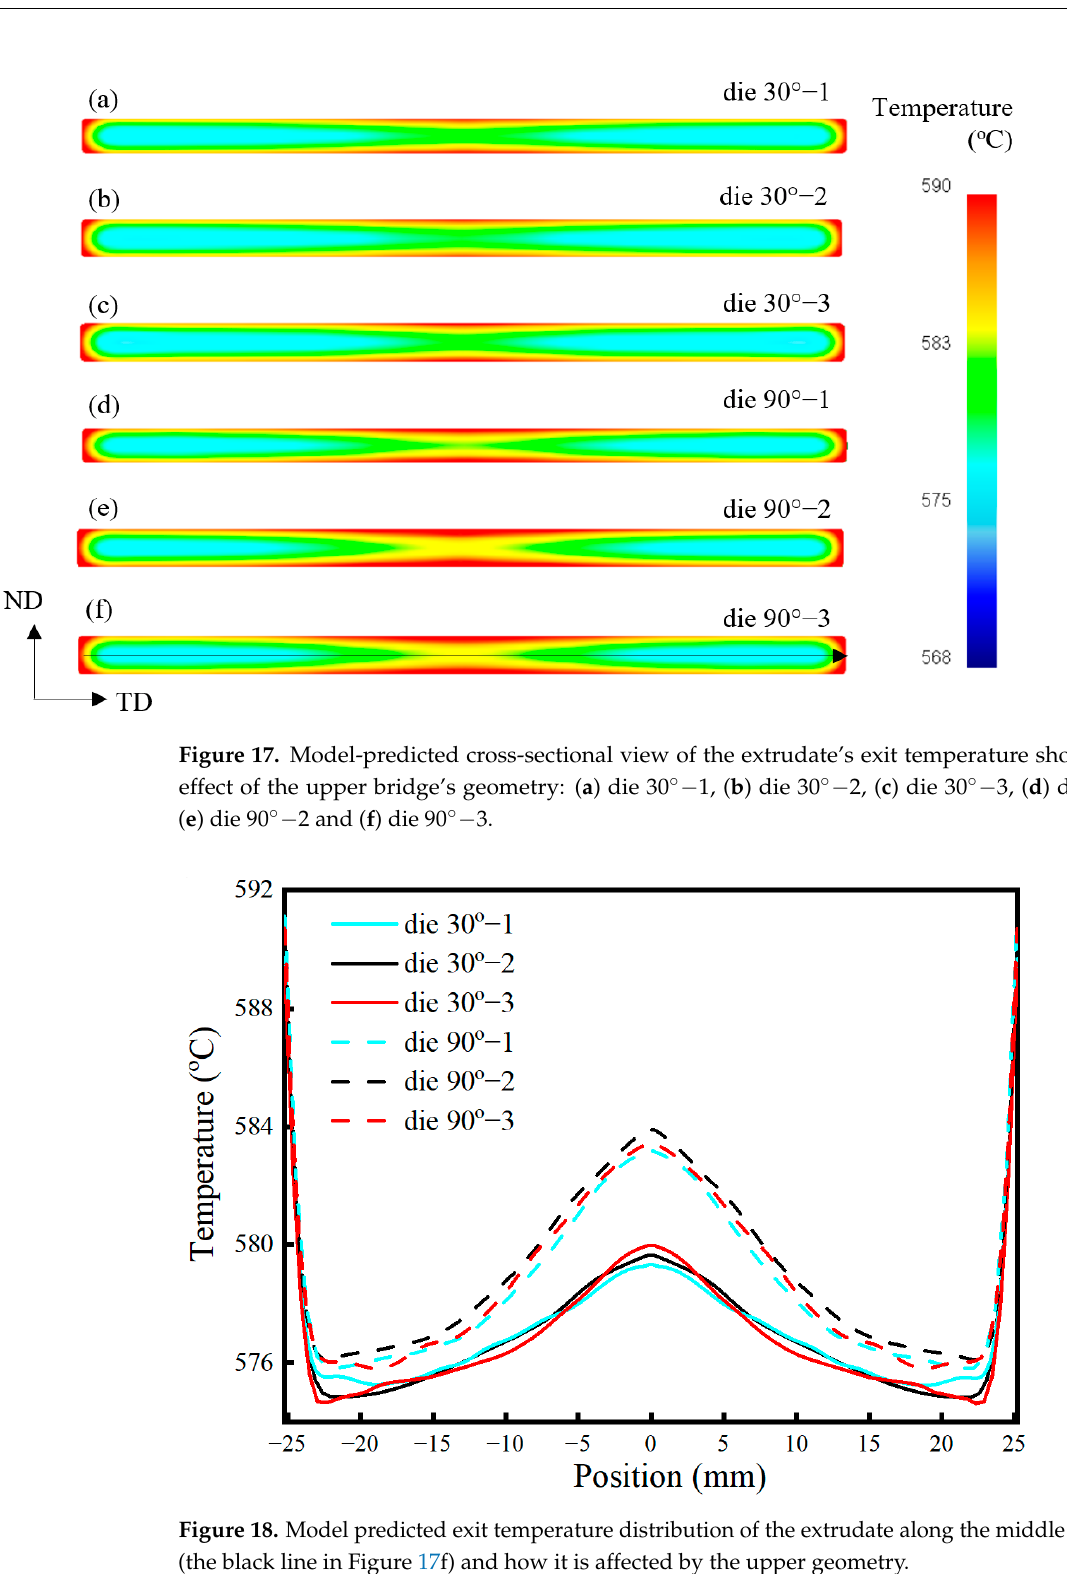
Figure 19. Strain distribution at the die exit of the profiles extruded using bridges with different upper bridge’s geometries. ( a ) die 30° − 1, ( b ) die 30° − 2, ( c ) die 30° − 3, ( d ) die 90° − 1. ( e ) die 90° − 2 and ( f ) die 90° − 3.